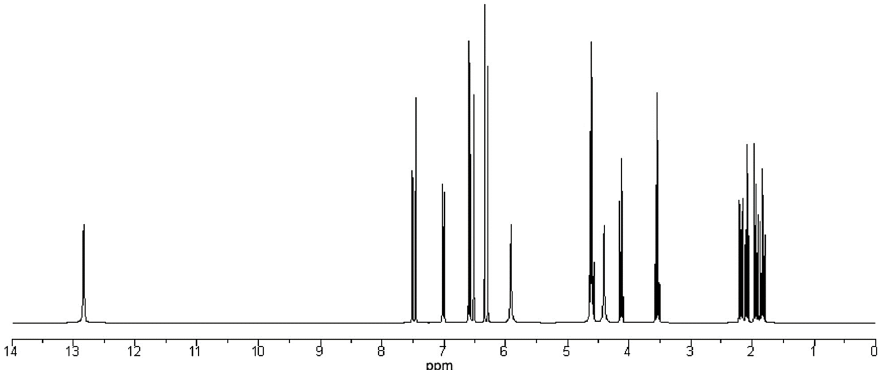
Figure 6. 1 H-NMR spectrum of 5-DCB complex. 5-DCB: Diester chlorogenoborate.